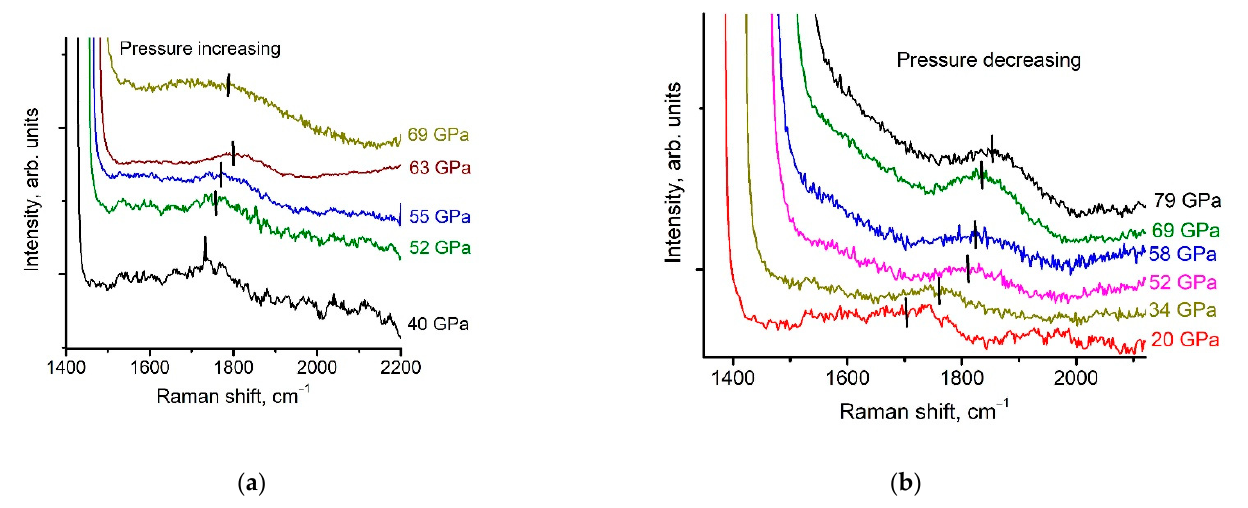
Figure 7. The behavior of the Raman spectra of a g -C 3 N 4 specimen as a function of pressure: ( a ) increasing pressure, ( b ) decreasing pressure after shear at 70 GPa.